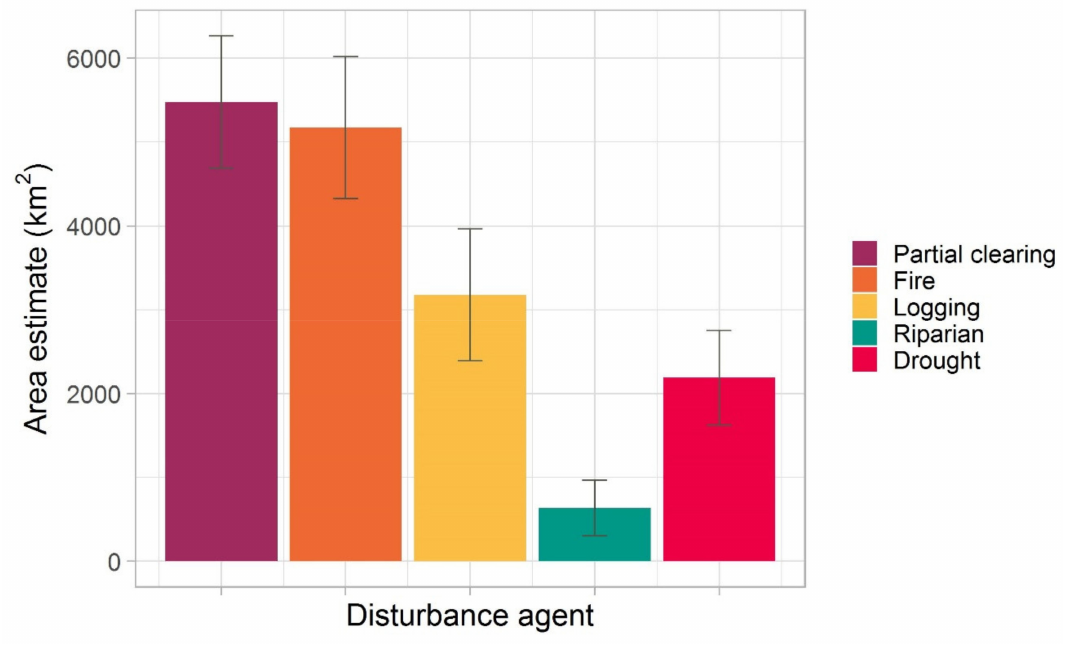
Figure 5. Area estimates including uncertainty range (i.e., confidence intervals) for five major forest disturbance agents for the Argentine Chaco for the period 1990 to